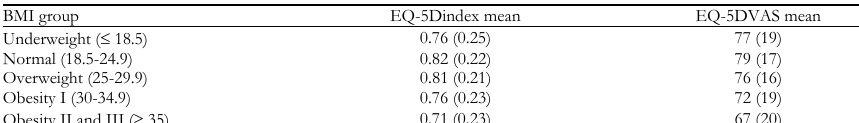
EQ-5D index mean and VAS mean for BMI class